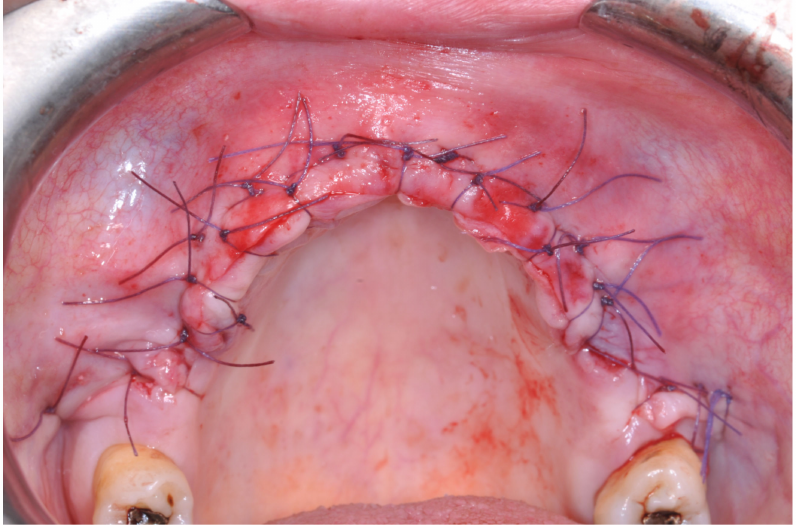
Figure 13. After